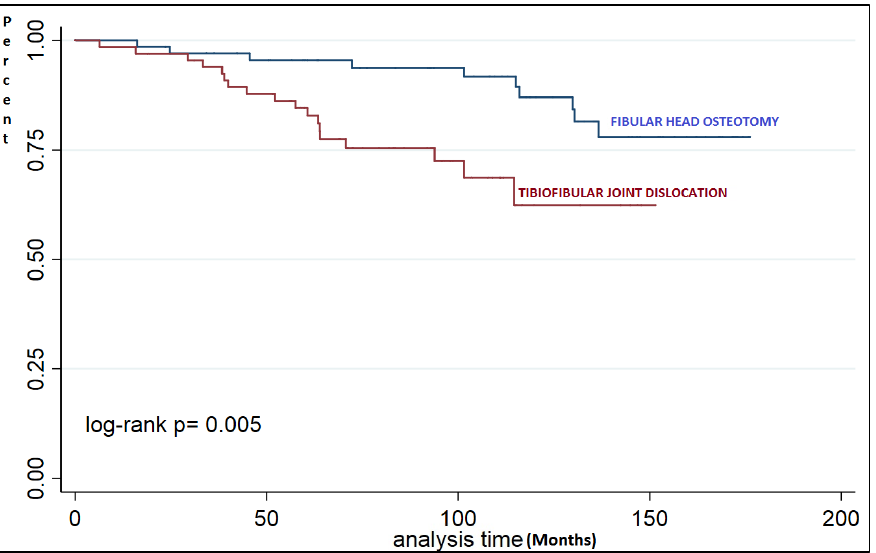
Figure 3. Survival analysis of non- overcorrected patients, FTA ≤ 180° (log-rank test). Table 6. Differences in the percentage of survival at different time points in non-overcorrected patients. Time Follow-Up (Months) Group 1. FHO ( n 52)